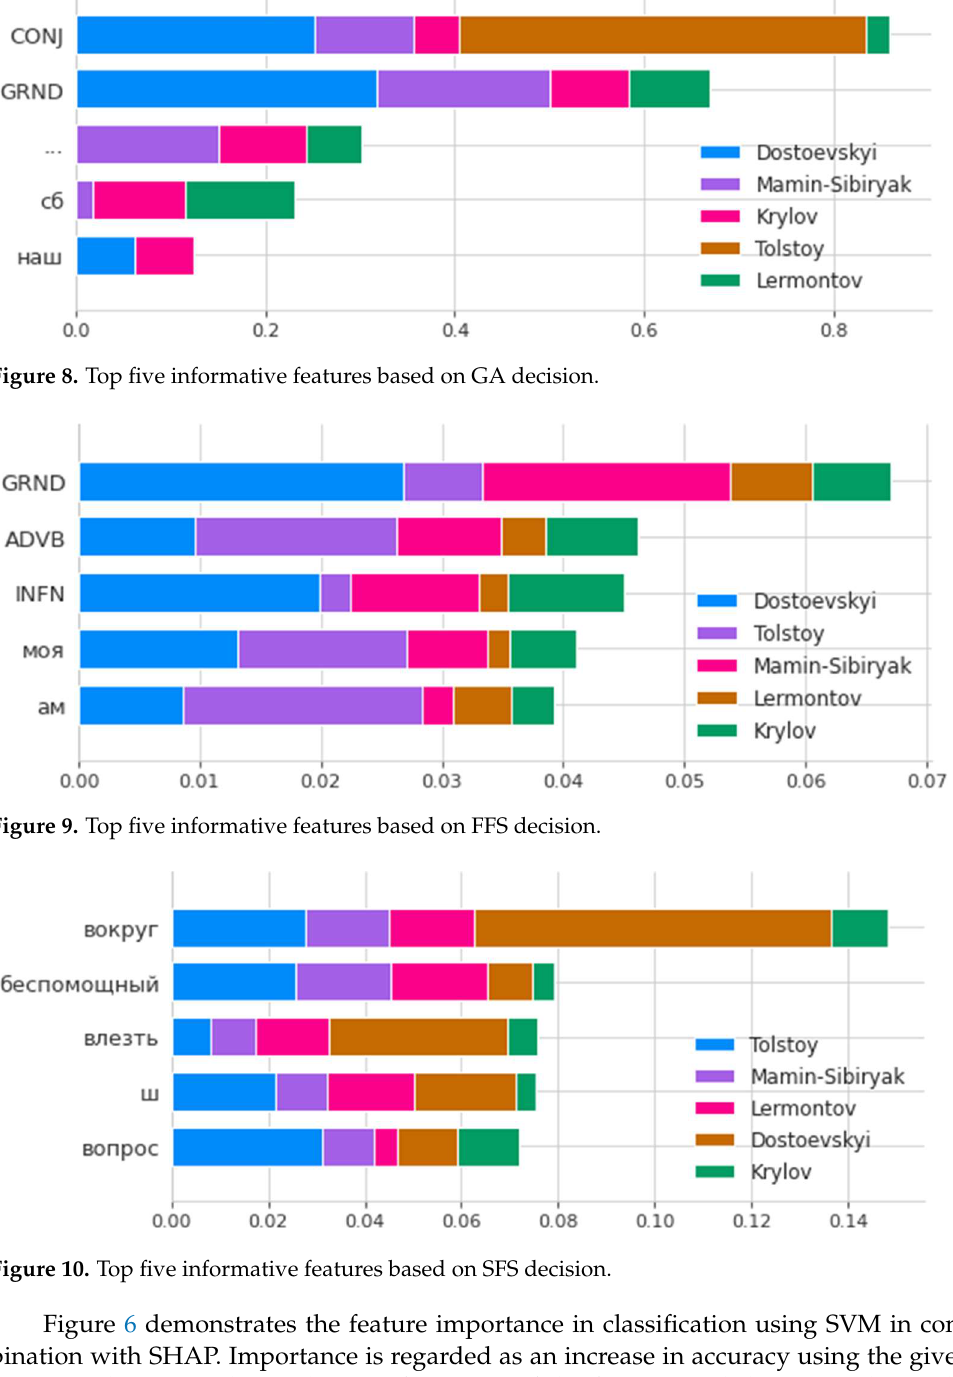
Figure 7. SHAP informative features.